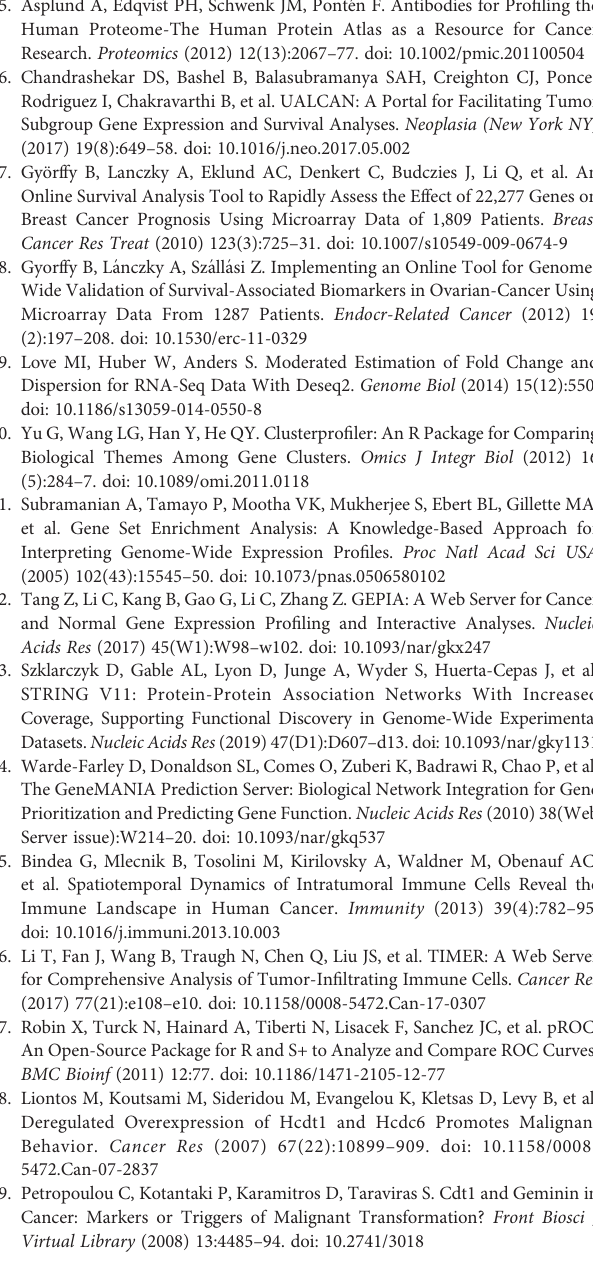
Supplementary Figure 1 | Results of enrichment analysis of CDT1 and its co- expressed genes. (A) The co-expression network of CDT1 gene. (B, C) GO and KEGG enrichment results of CDT1 and its co-expressed genes. Supplementary Figure 2 | Interaction network of CDT1 and its most co- expressed genes on STRING. Supplementary Figure 3 | Expression, prognosis of MCM9 and its correlation with CDT1 in HCC. (A) Spearman correlation analysis of the correlation between MCM9 and CDT1 at the transcriptional level. (B) MCM9 expression between HCC tissues and normal liver tissues. (C) Survival analysis of MCM9 in HCC. * p < 0.05, ** p < 0.01, *** p <